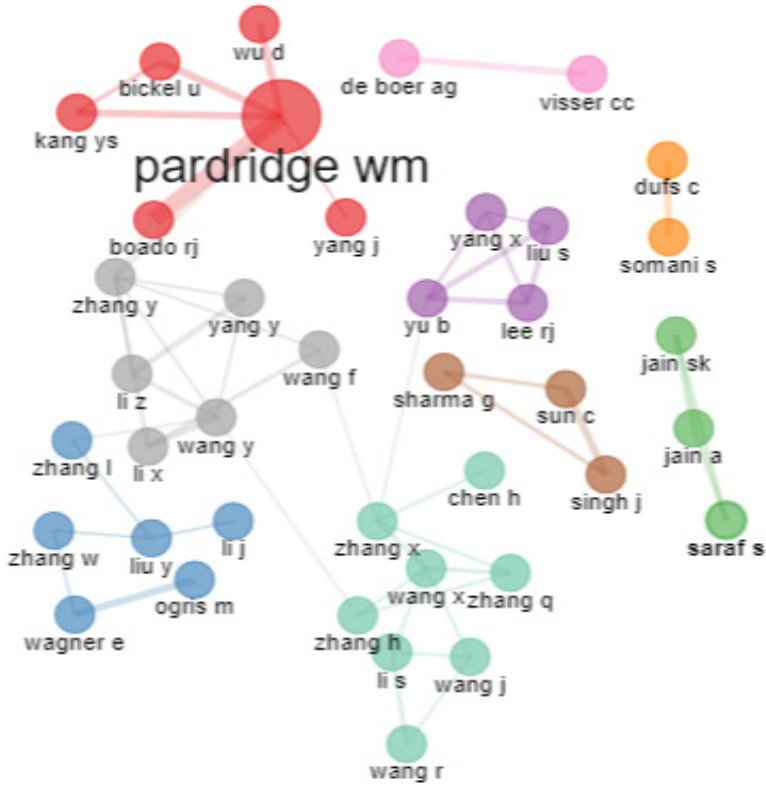
Figure 10. Collaboration network. Source: Authors’ elaboration using the Bibliometrix R-package.